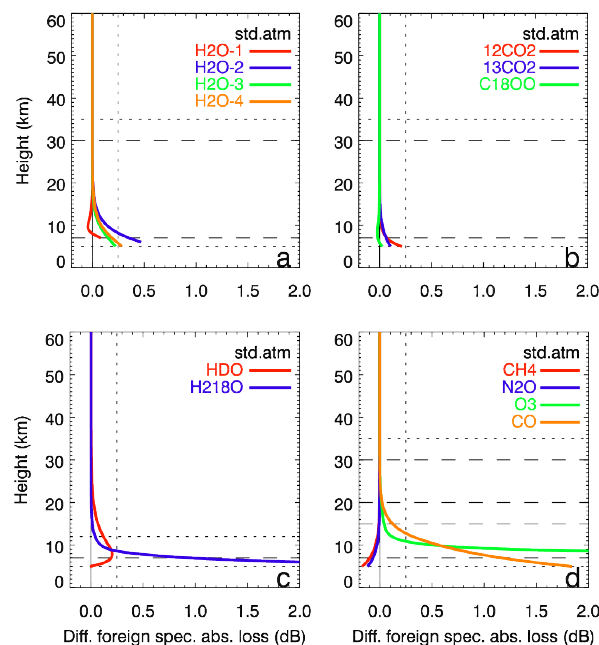
Fig. 5. Differential foreign species absorption loss for the 13 channel pairs listed in Table 1, for the FASCODE STD atmosphere. The vertical dotted line marks the boundary where the foreign species loss, if transgressing it, enters into the favourable range for target species loss. The horizontal dotted and dashed lines mark target and threshold requirements, respectively, regarding the vertical range within which trace species shall be retrieved.